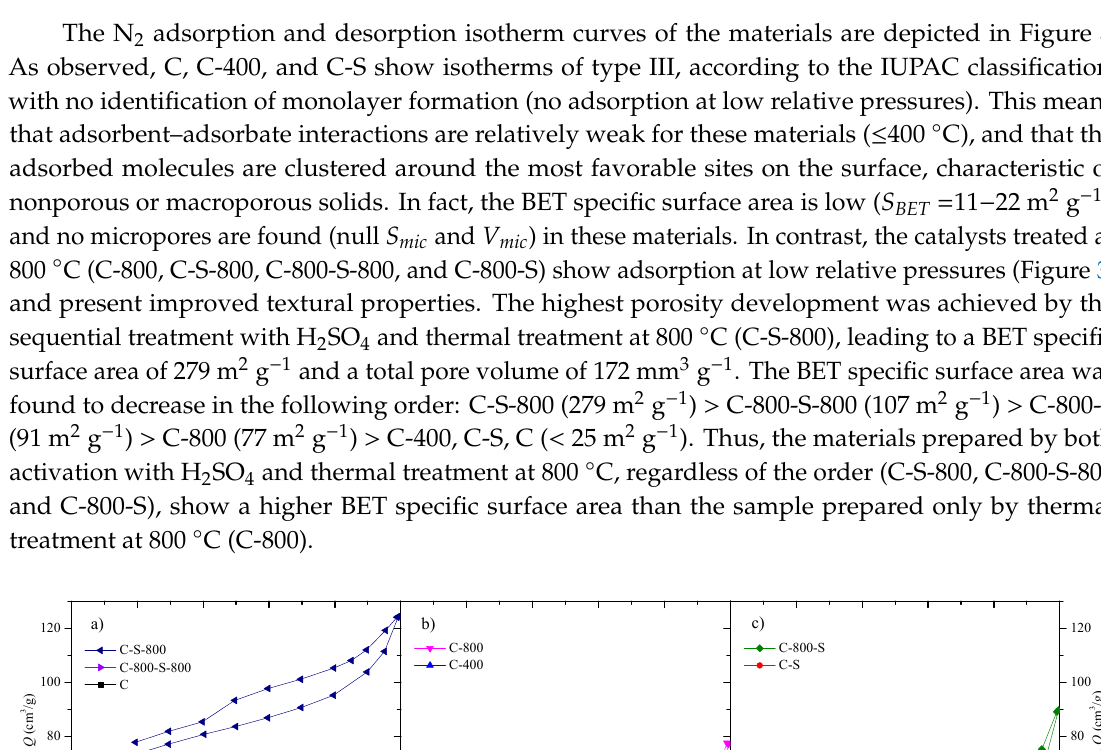
Table 2. Acid ‐ base characterization of the catalysts.